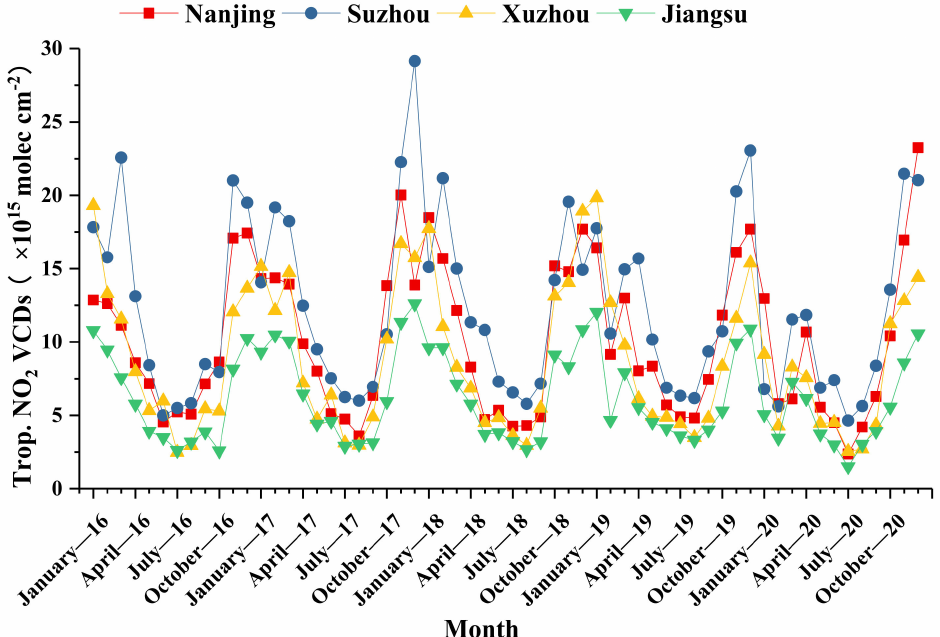
Figure 2. Comparison of monthly average tropospheric NO 2 VCDs of Nanjing, Suzhou, Xuzhou, and Jiangsu